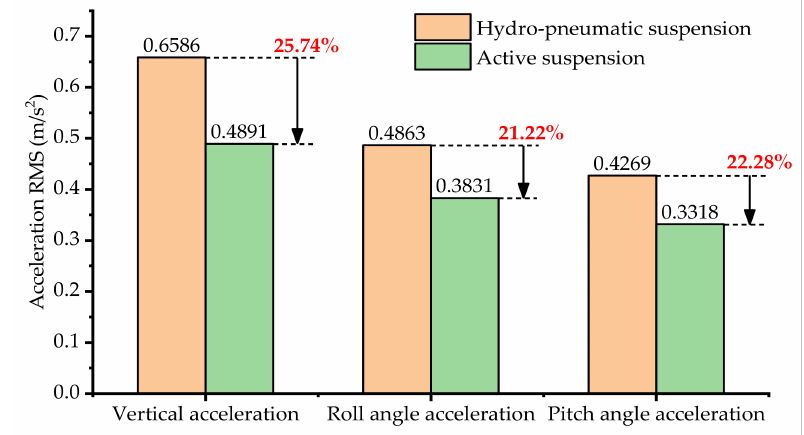
Figure 14. Comparison of acceleration